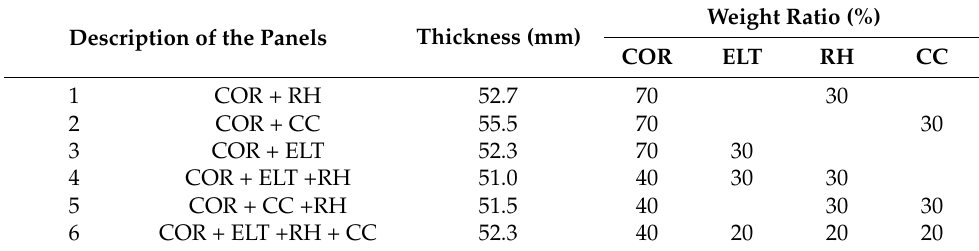
Table 3. Weights and densities of the manufactured samples.